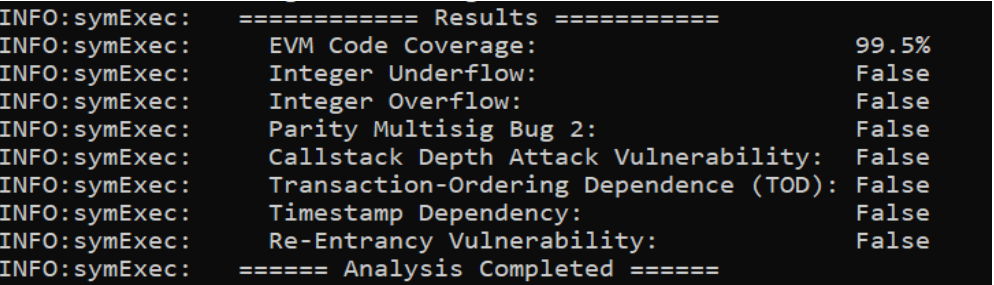
Figure 15. Security analysis of the proposed smart